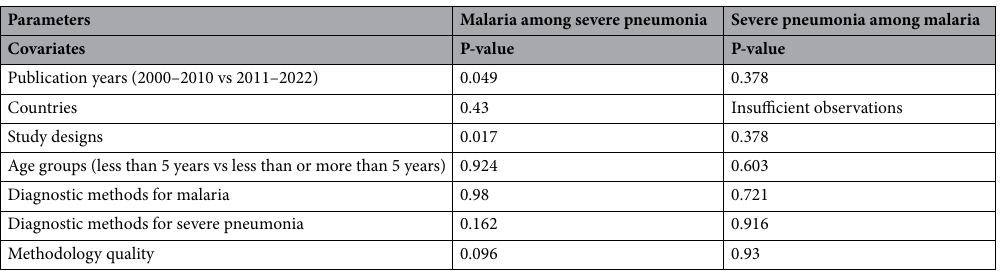
Table 2. Meta-regression results.